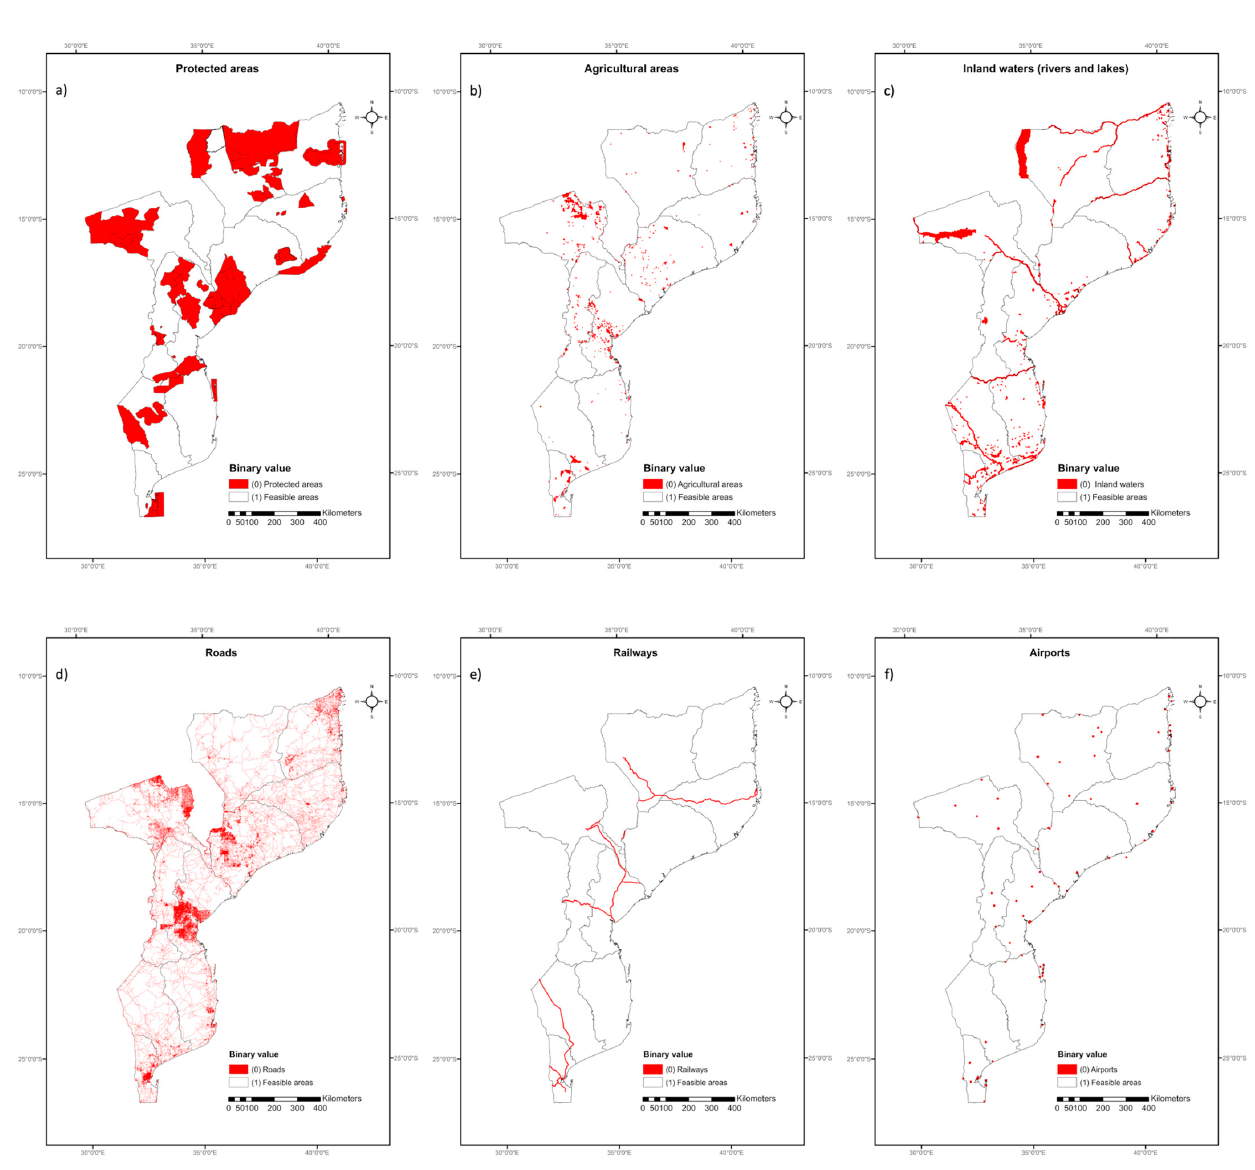
Figure A1. Maps with constraints considered for the analysis of the spatial suitability of off-grid solar PV microgrid projects in Mozambique. ( a ) Protected areas, ( b ) agricultural areas, ( c ) inland waters, ( d ) roads, ( e ) railways, and ( f ) airports.